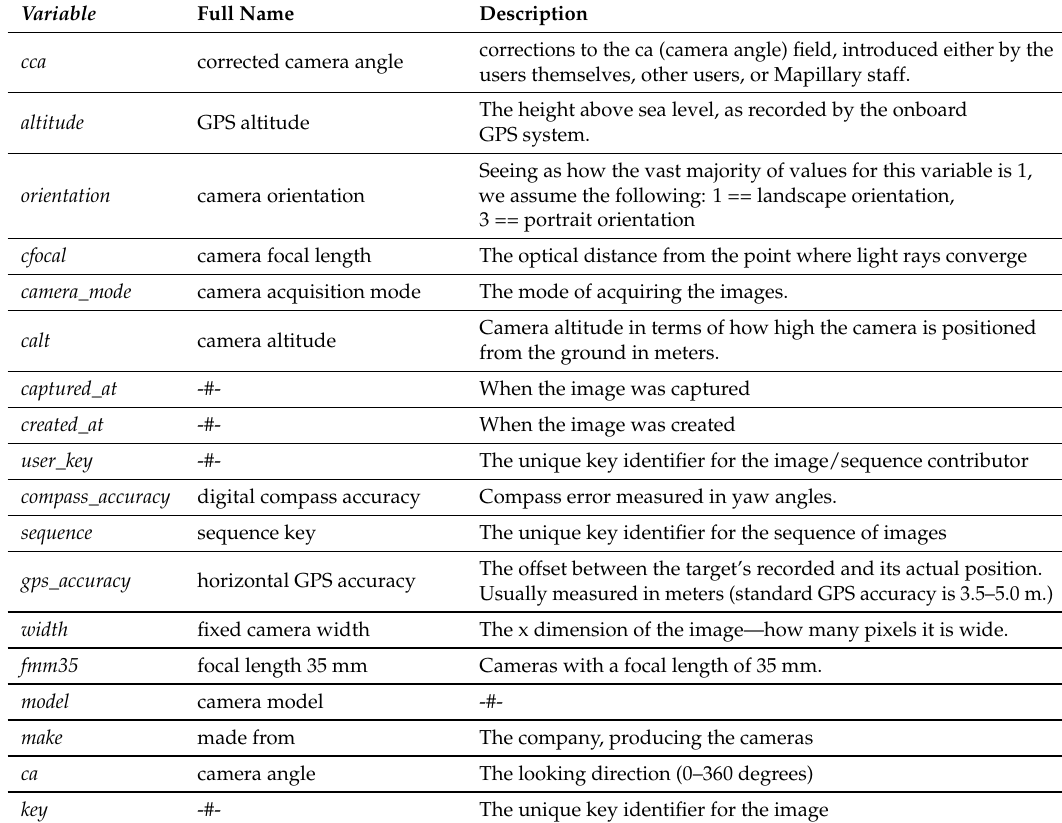
Table A2. Description of the available variables on the Mapillary